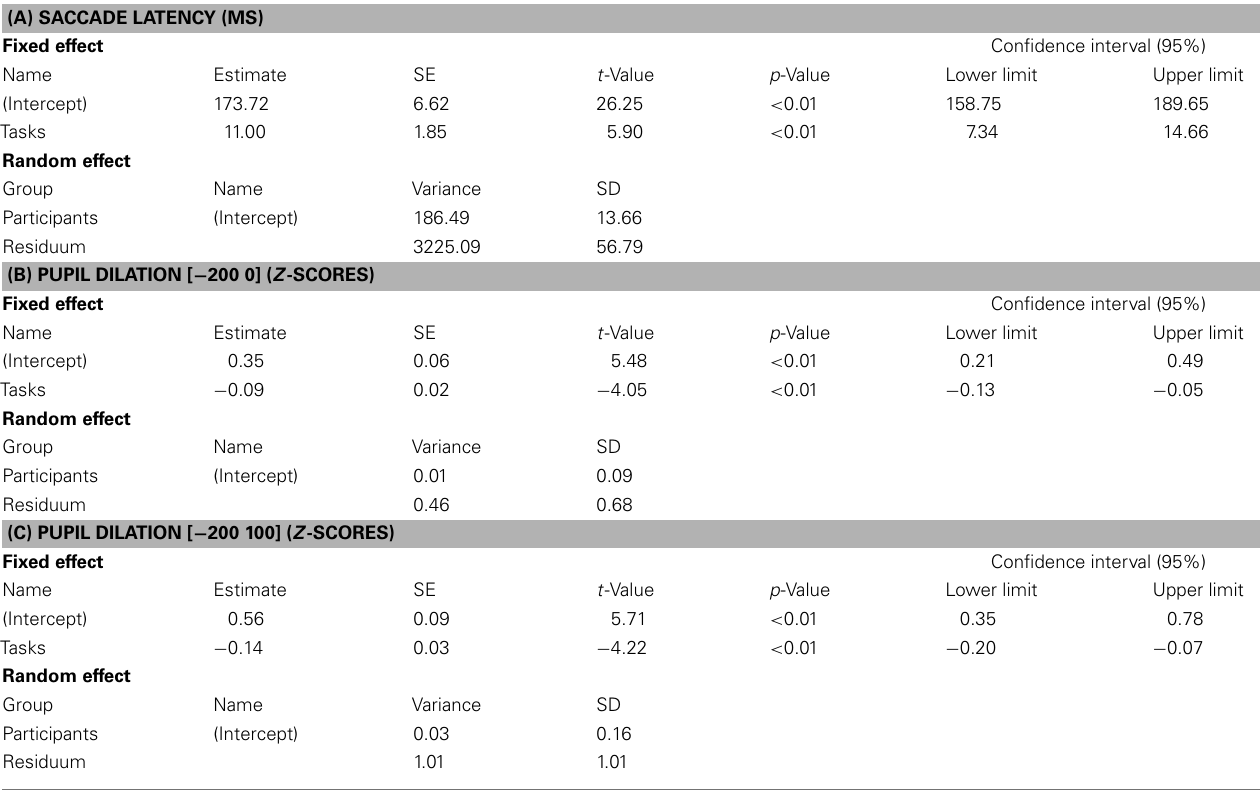
Table 1 | Summary of the mixed-effects models for saccade latency (A) and pupil dilations (B,C).